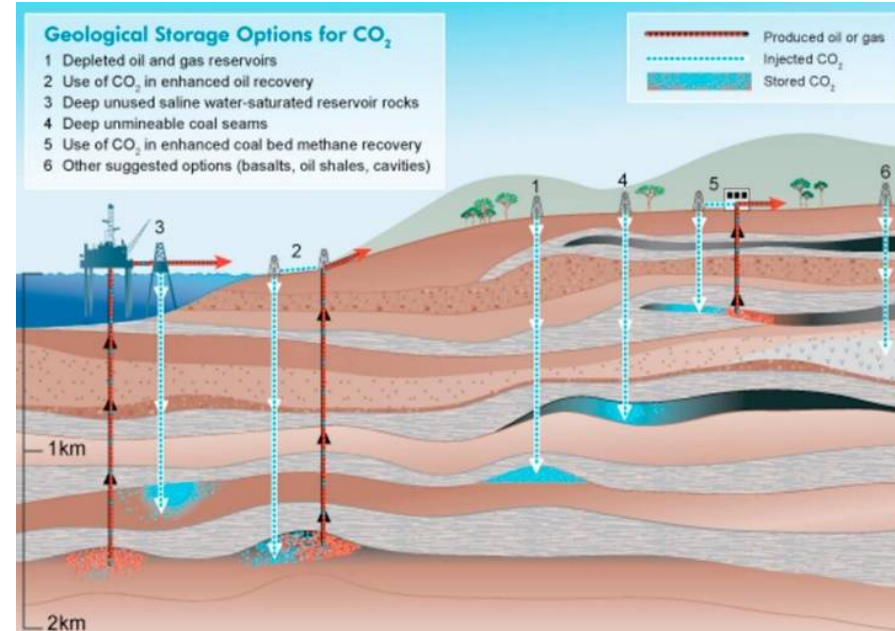
Figure 17. Some geological storage options for CO 2 . Reproduced with permission from [237], Elsevier, 2017.